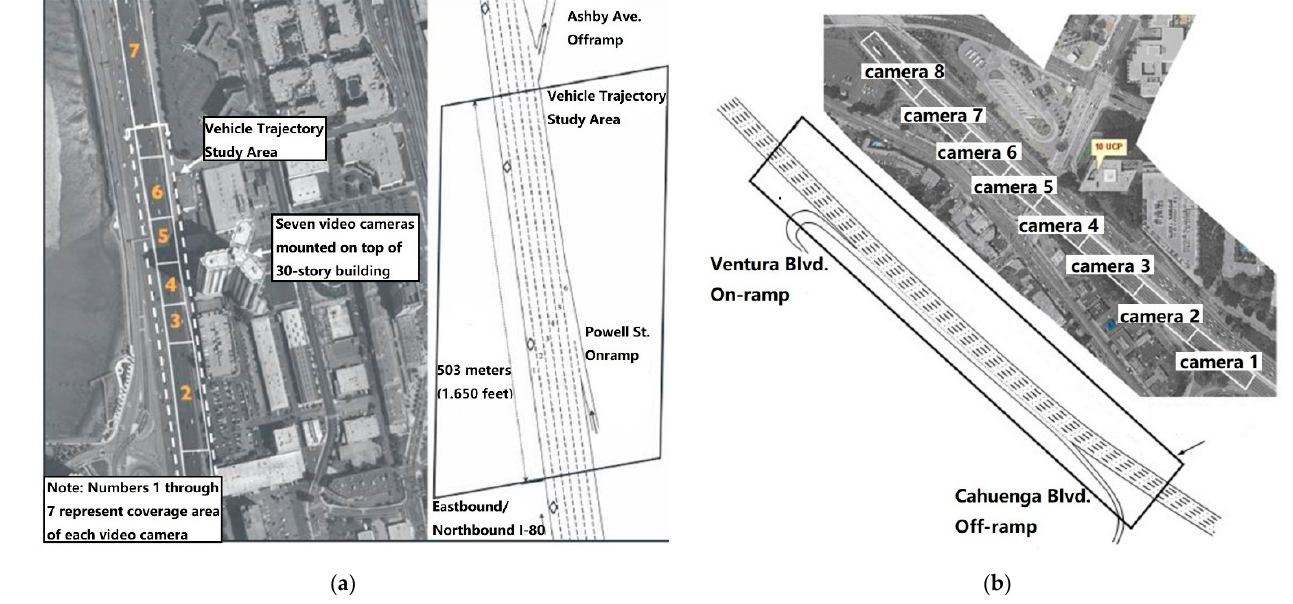
Figure 4. Sampling section of the dataset: ( a ) I-80 section; ( b ) US-101 section.